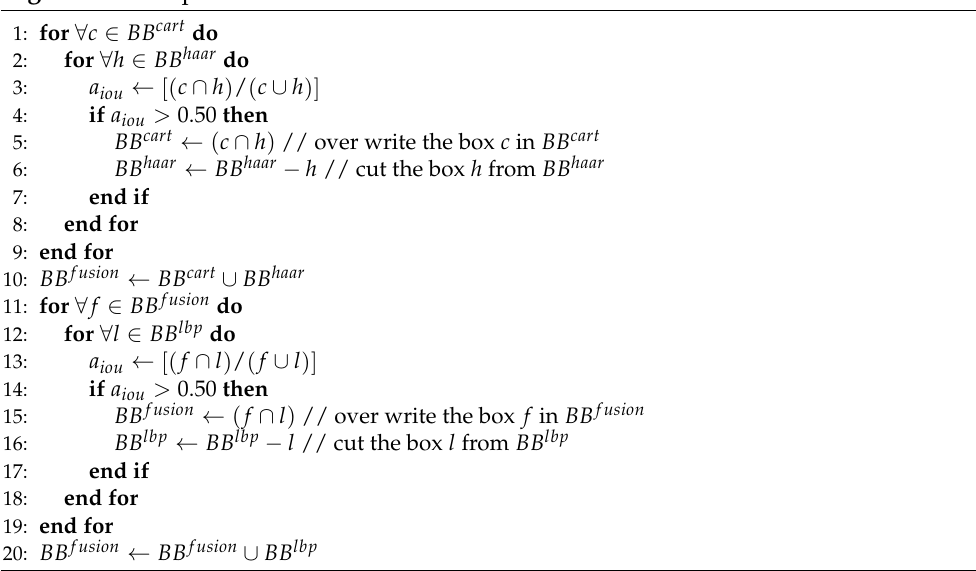
Algorithm 3 Proposed Face fusion